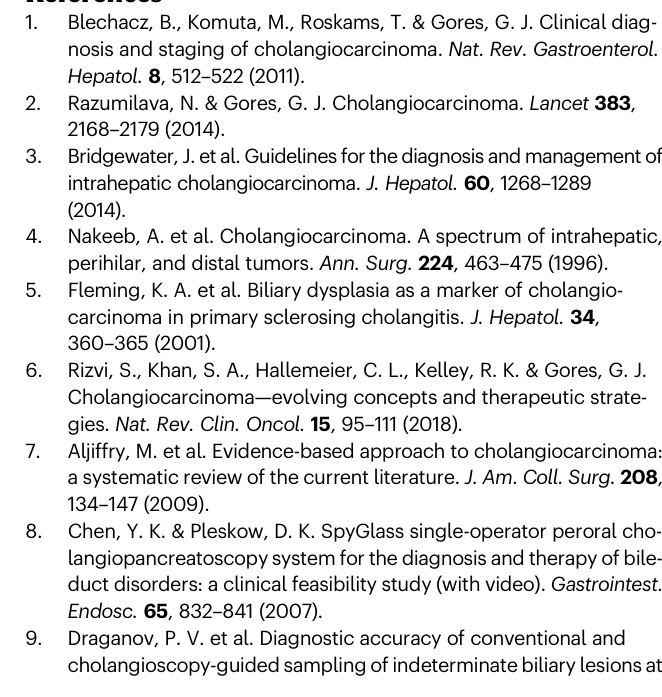
Fig. 8 | Two-layeredtissue phantom experimentsrepresenting epithelium and underlying connective tissue. a Schematic of the two-layered tissue phantom experiment. b Total re fl ectance signals collected from two-layered phantoms at r 1 =120 µ m (solid lines) and r 2 =240 µ m (dashed lines) source-detector separations for reduced scattering coef fi cients of the bottom layer µ ' s =1mm − 1 (red), 1.5mm − 1